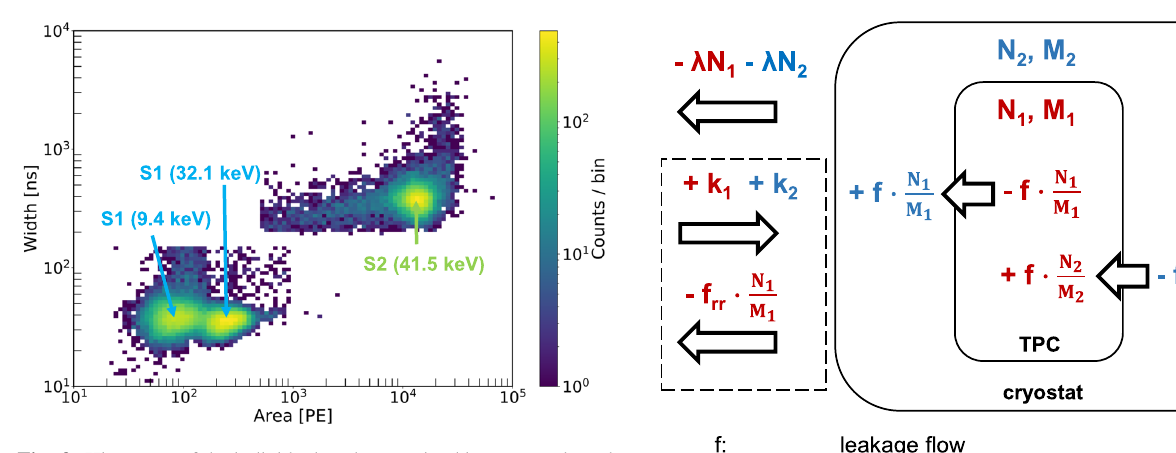
Fig. 3 Histogram of the individual peaks contained in events selected as originating from 83m Kr: the two populations at smaller signal width correspond to the 9.4 keV and 32.1 keV S1 signals, respectively. The S2 signals from the summation peak at 41.5 keV are visible at larger area and width